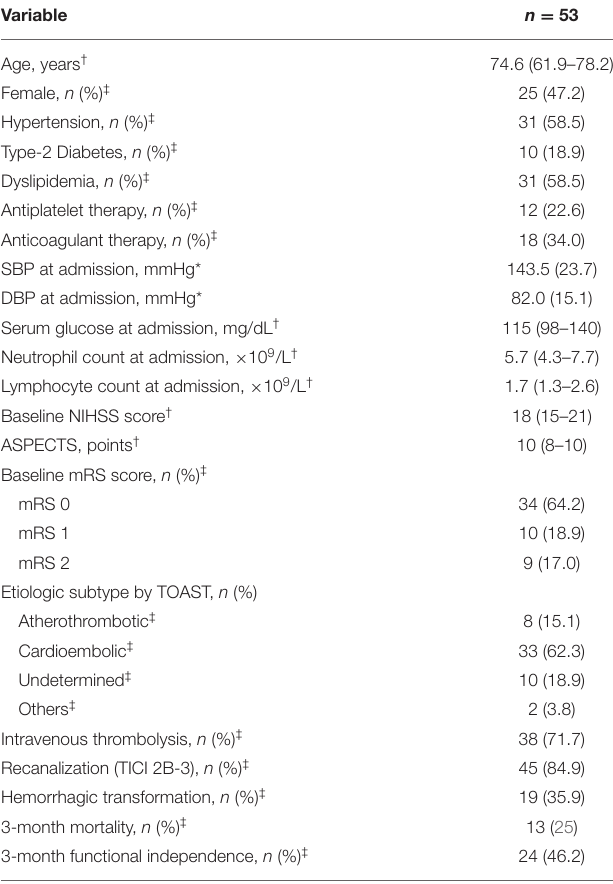
TABLE 1 | Patients clinical